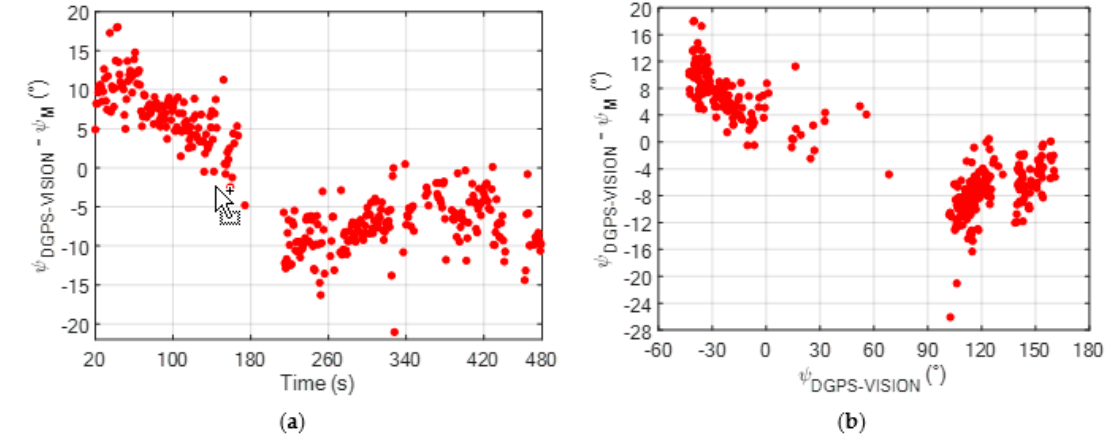
Figure 6. ( a ) Time variation of ψ ERR for the non-calibrated magnetic heading ( ψ M ) during the flight test; ( b ) Variation of ψ ERR for the non-calibrated magnetic heading ( ψ M ) as a function of the reference heading solution obtained using the DGPS-vision algorithm